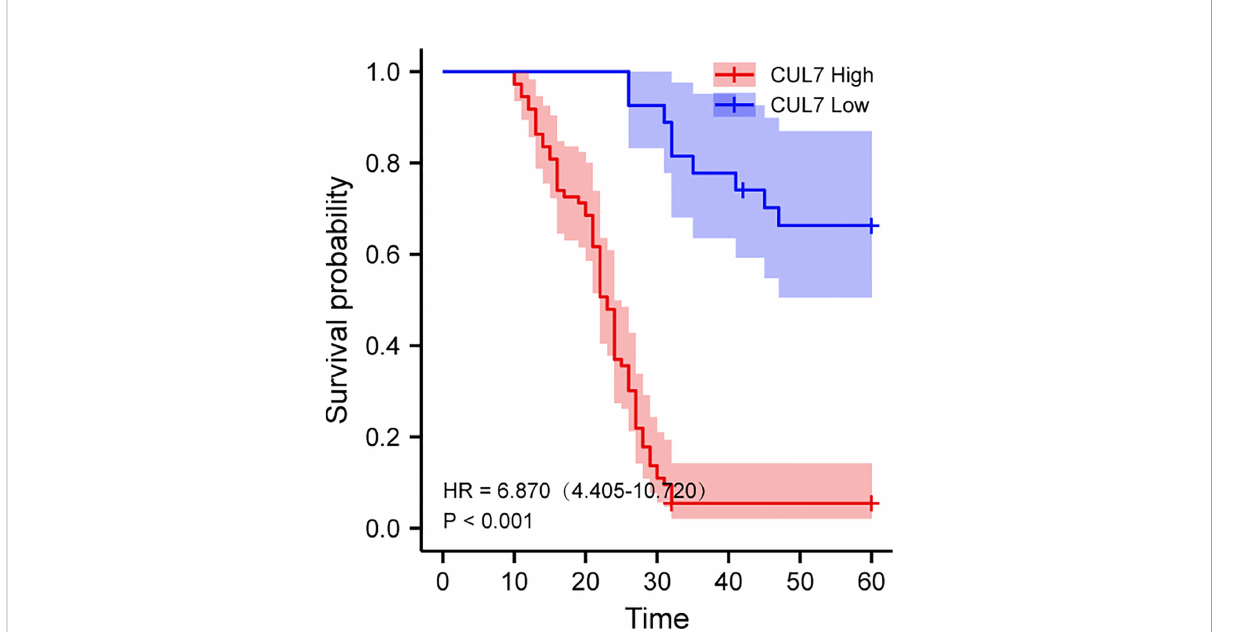
FIGURE 9 Kaplan-Meier overall survival (OS) analysis of COAD patients with high and low expression levels of CUL7.